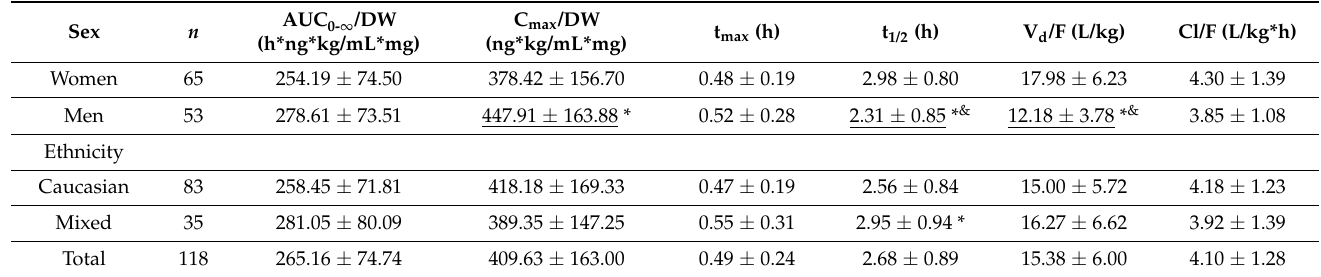
Table 3. Pharmacokinetic parameters of rasagiline according to sex and ethnicity.